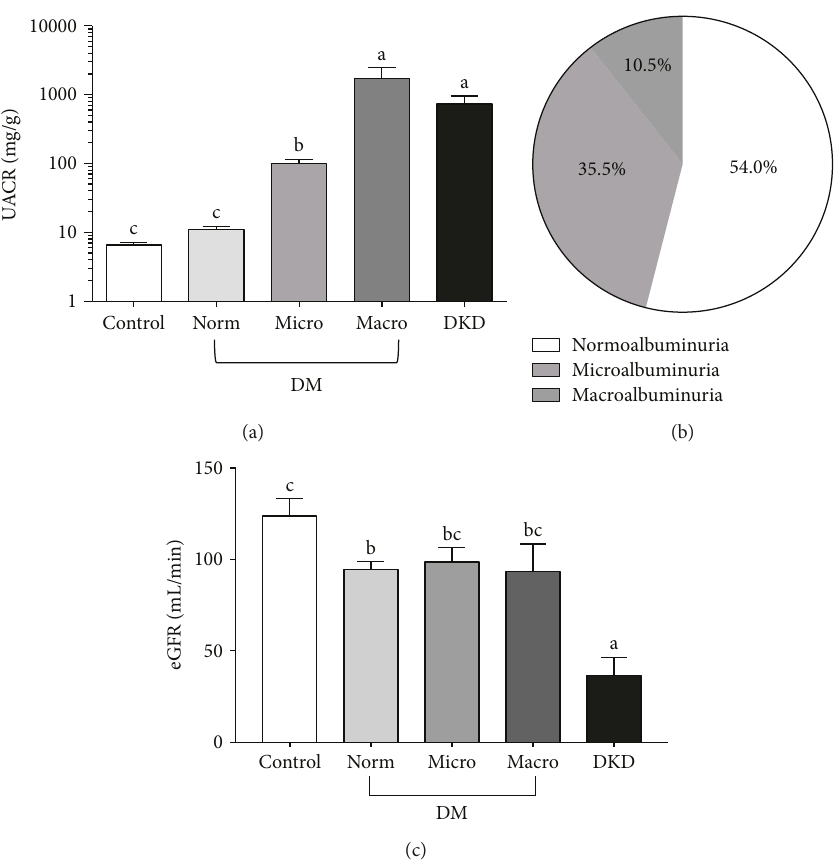
Figure 1: Biochemical assessment of diabetic kidney disease. (a) Urinary albumin-to-creatinine ratios (UACRs) among nondiabetic controls, diabetics with no known kidney disease (DM), and diabetics with diagnosed diabetic kidney disease (DKD). Diabetic patients were divided into three groups; normo-, micro-, and macroalbuminuria based on their UACR levels. Data are represented as mean ± standard error about the mean (SEM). Labels without a common letter indicate a signi fi cant di ff erence between the groups ( p < 0 05 ). (b) The proportion of diabetic patients with no known kidney disease with UACRs in the normo- ( UACR ≤ 30mg/g ), micro- ( 30 ≤ UACR ≤ 300mg/g ), and macroalbuminuria ( 300 mg/g ≤ UACR ) ranges. (c) Average estimated glomerular fi ltration rates (eGFR) among nondiabetic controls, diabetics with no known kidney disease (DM), and diabetics with diagnosed DKD. Members of the DM group are subdivided into normo-, micro-, and macroalbuminuria groups, as in (a). Data are represented as mean ± SEM . Labels without a common letter indicate a signi fi cant di ff erence between the groups ( p < 0 05